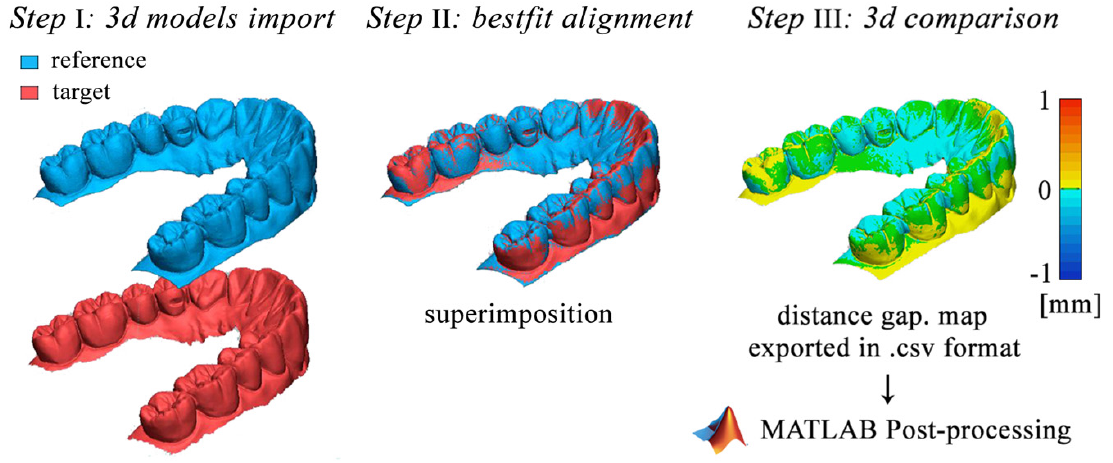
Figure 3. Example of a 3D comparison procedure performed by using Geomagic’s software.